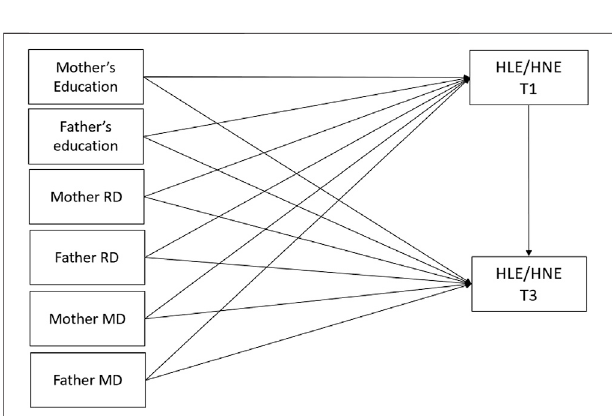
FIGURE 2 | The base-model for parental measures predicting HLE and